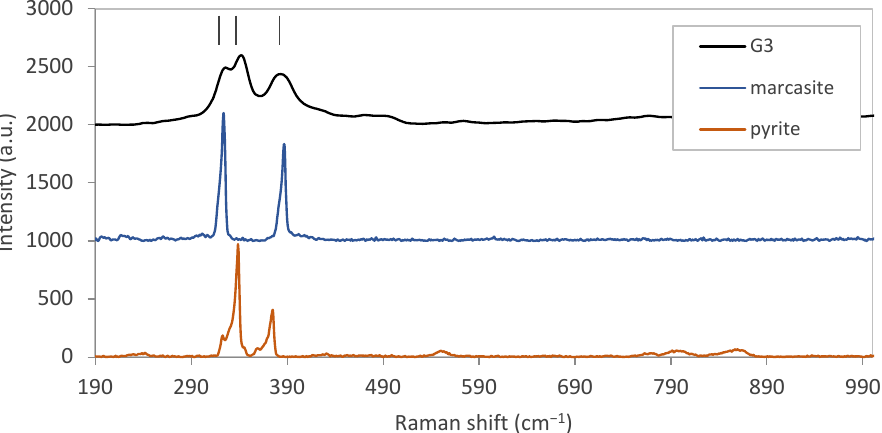
Figure 11. ( a ) The XRD pattern of pyrite powder sample with simulated patterns of reference cards of ( b ) pyrite (JCPDS 3-065-1211) and ( c ) hematite (JCPDS 33-0664).